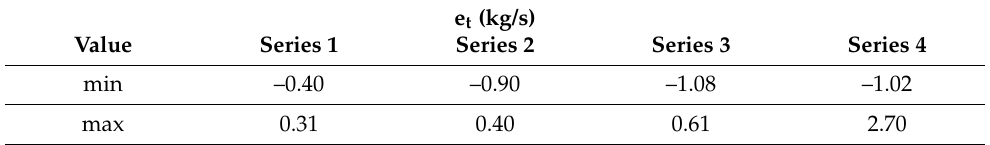
Table 5. Extreme values of the prediction error obtained on the basis of forecasts for four data